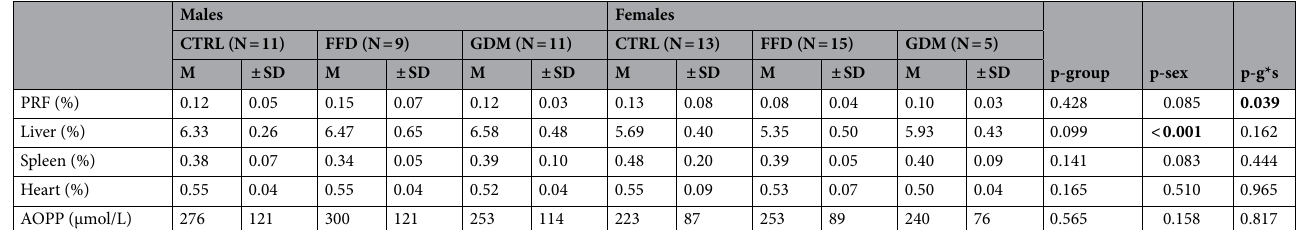
Table 1. Relative organ weight and biochemical data of the offspring. Significant values are in bold. CTRL offspring of dams consuming a control diet, FFD offspring of dams administered a fast-food diet (cheeseburgers), GDM offspring of dams with gestational diabetes mellitus, g*s group-sex interaction, PRF perirenal fat, AOPP advanced oxidation protein products; organ and fat-pad weights are expressed as a percent of body weight, M mean, SD standard deviation, N number of